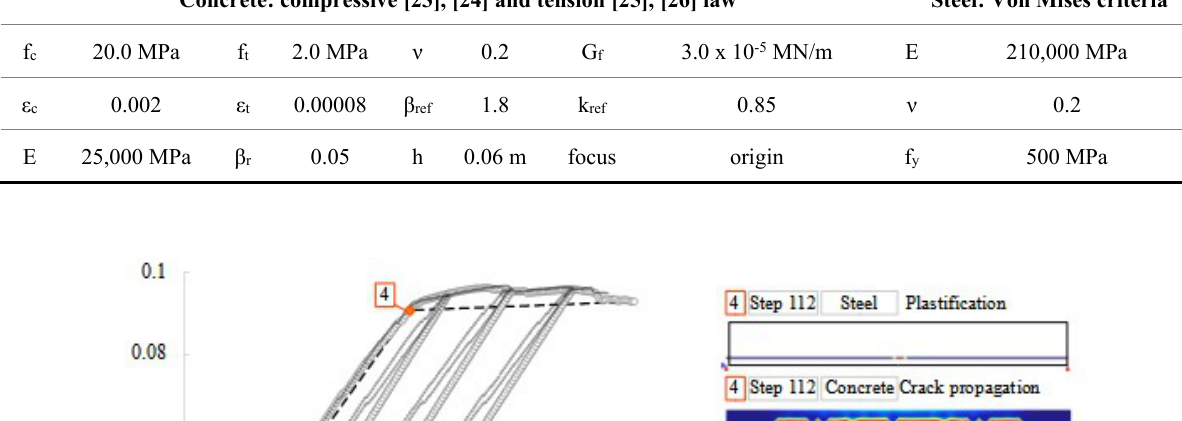
Table 4. Material parameters: concrete and steel.